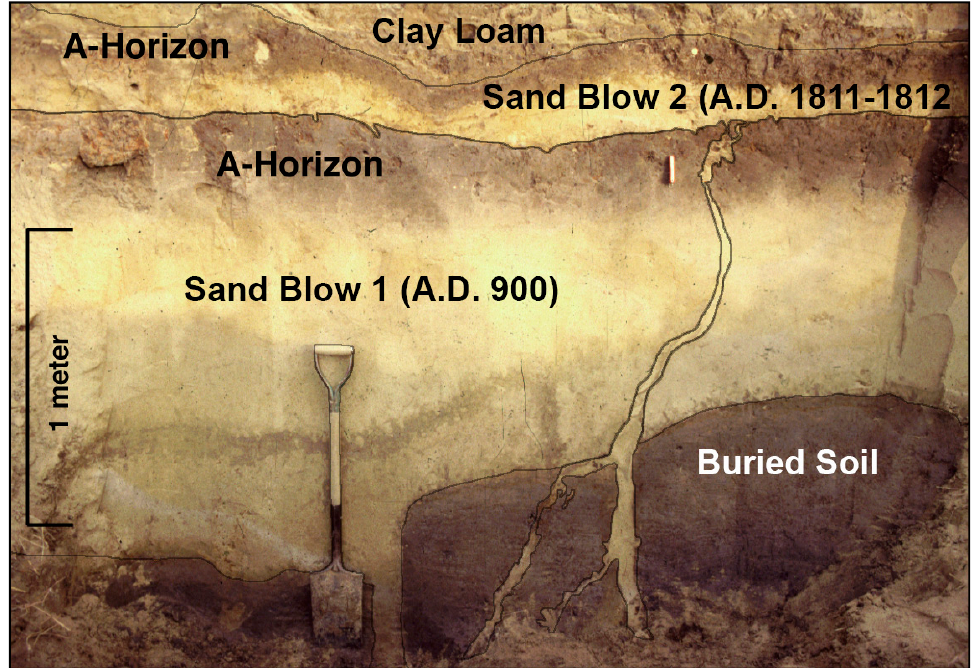
Figure 8. Two generations of sand blows and related feeder dikes exposed in a drainage ditch in the northern portion of the New Madrid seismic zone [119]. The large lower sand blow was subjected to soil-forming processes for about 900 years resulting in the formation of a ~37-cm-thick soil A-horizon.